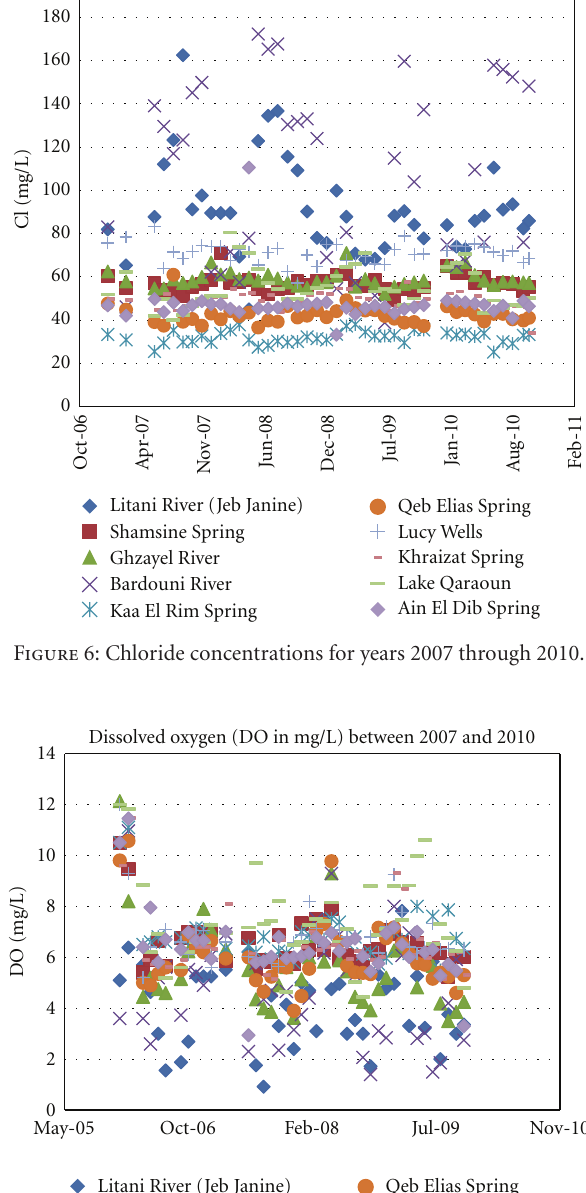
over the years. The only two exceptions are not surprisingly the Berdawni river and the Litani River.